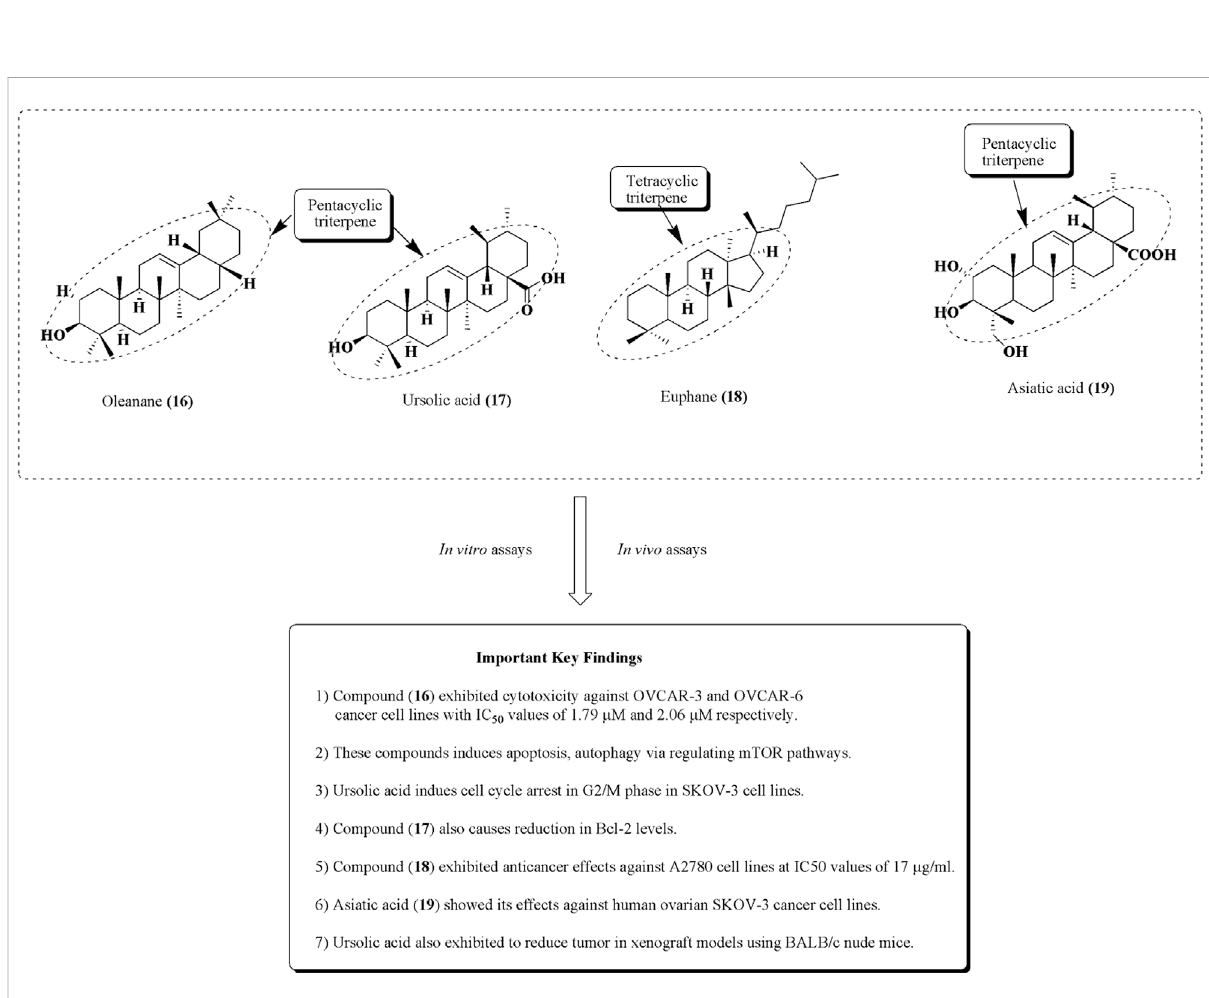
FIGURE 20 Structures of some triterpenes as potential anticancer agents against ovarian cell lines. Anti-ovarian cancer activity of these tetracyclic and pentacyclic triterpenes was assessed by performing in vitro and in vivo assays.